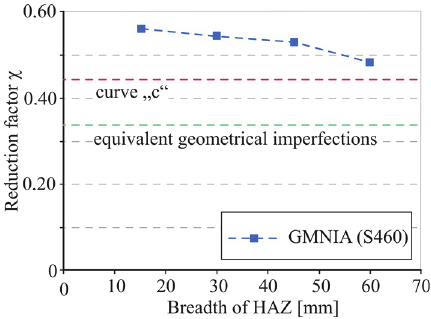
Fig. 19. comparison of numerical results with buckling curves for steel